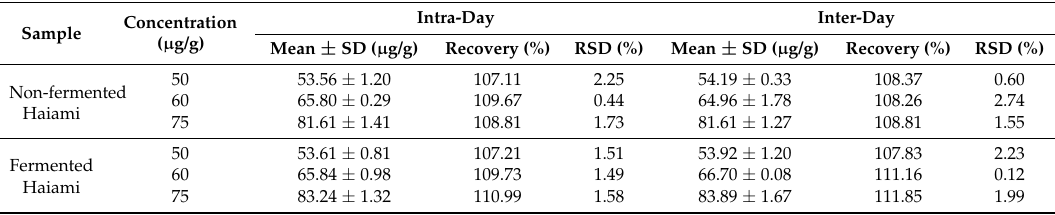
Table 2. Accuracy and precision of γ -oryzanol analysis for Oryza sativa cv. Haiami rice